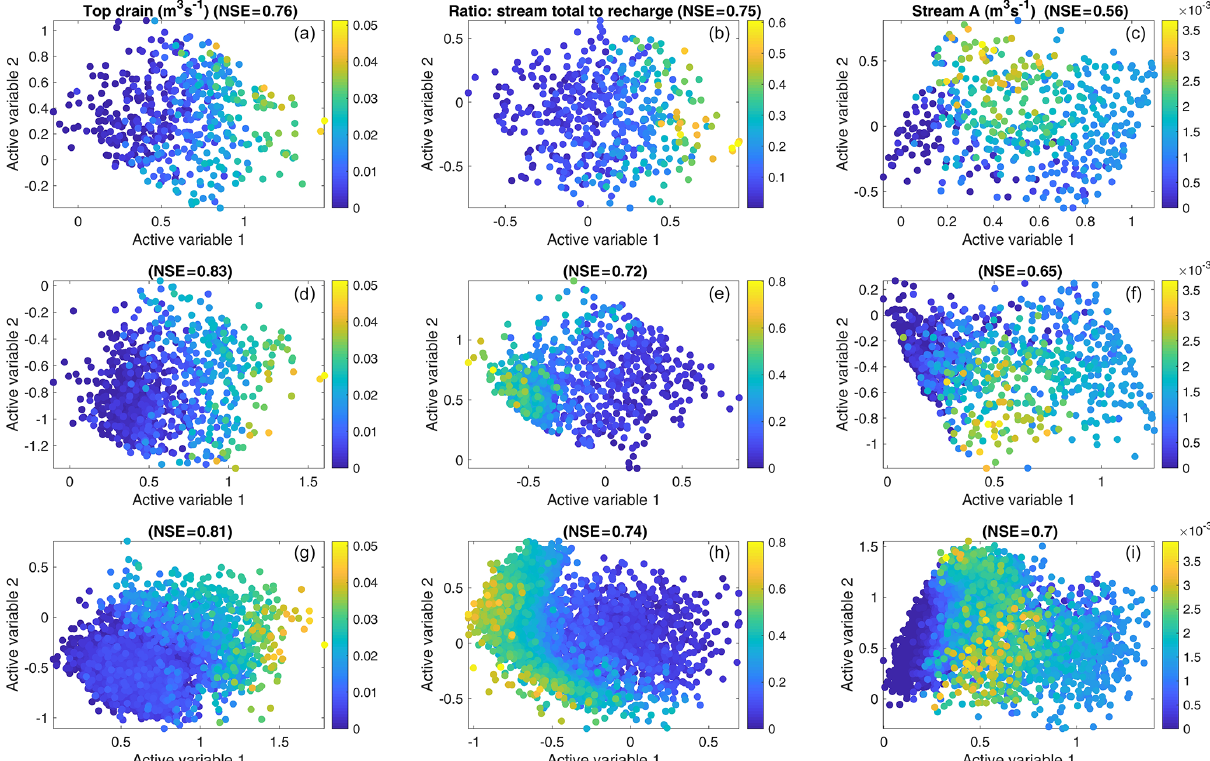
Figure 4. Two-dimensional active subspaces for three of the behavioral targets: top drain (limited flooding – target 1), ratio (target 5) and flow in stream A (target 4). The observed values are illustrated by the color. (a–c) shows the initial 500 samples, (d–f) the first 1000 samples and (g–i) all 10000 samples. NSE values in the titles correspond to fitting the third-order meta-model according to Eq. (13) to the